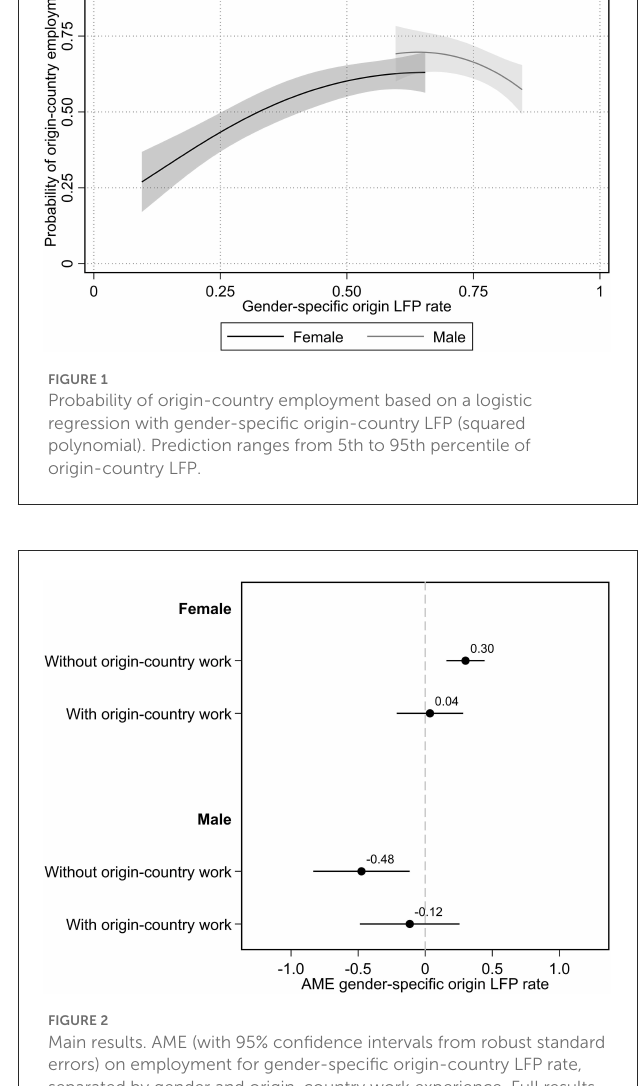
compared to women coming from low-LFP countries. For men,